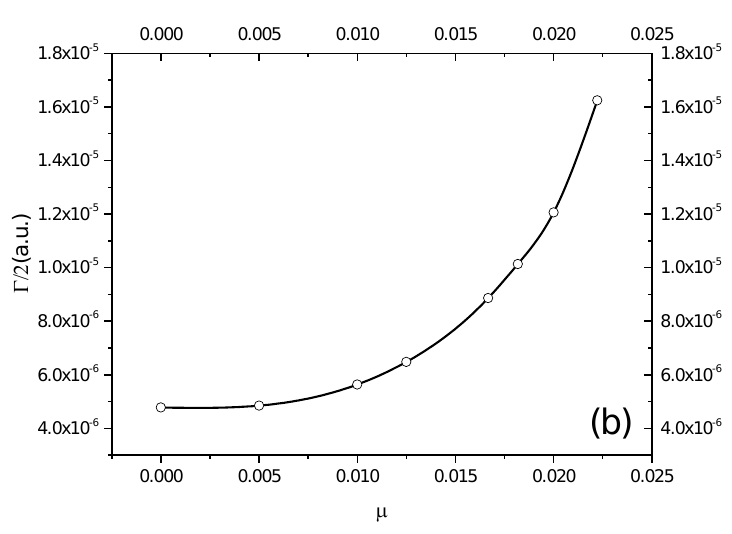
Figure 1. D -wave ( a ) resonance energy and ( b ) half-width for the H(2d-1) state as a function of μ = 1/ D .